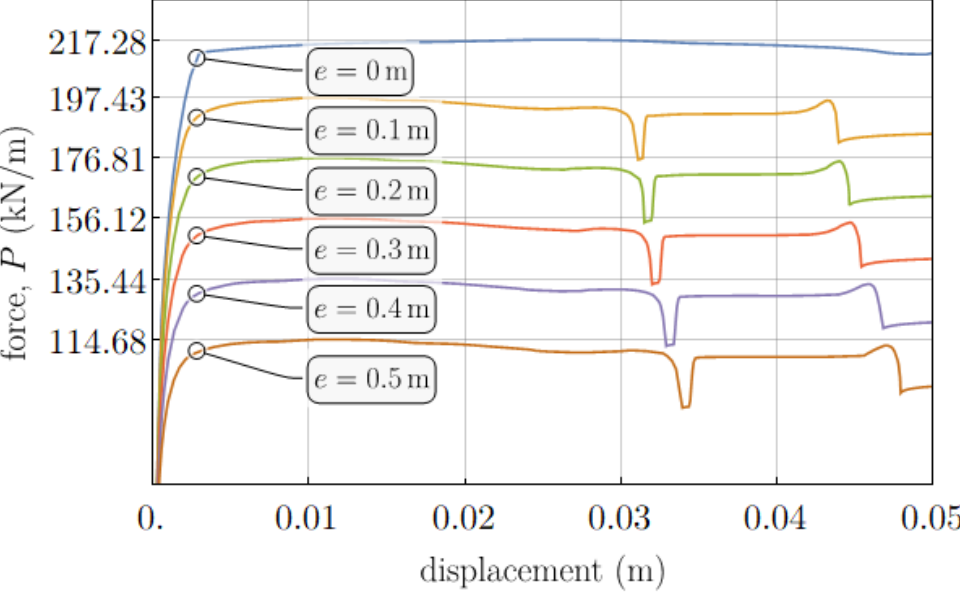
Figure 2: Reaction in displaced nodes (as a function of displacement) obtained in deterministic calculations. Maximum values (bearing capacities) are marked on the vertical